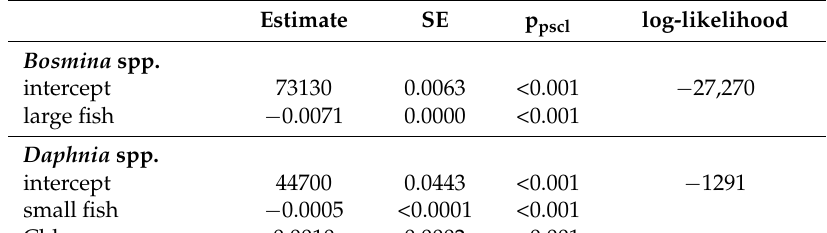
Table 2. Multiple GLMMs based on Markov chain Monte Carlo method showing the predictors for the changes in the abundance (ind. L ´ 1 ) of Bosmina spp. and Daphnia spp. for the summer period. Estimated value, standard error (SE), p-value (p pscl ), and log-likelihood.